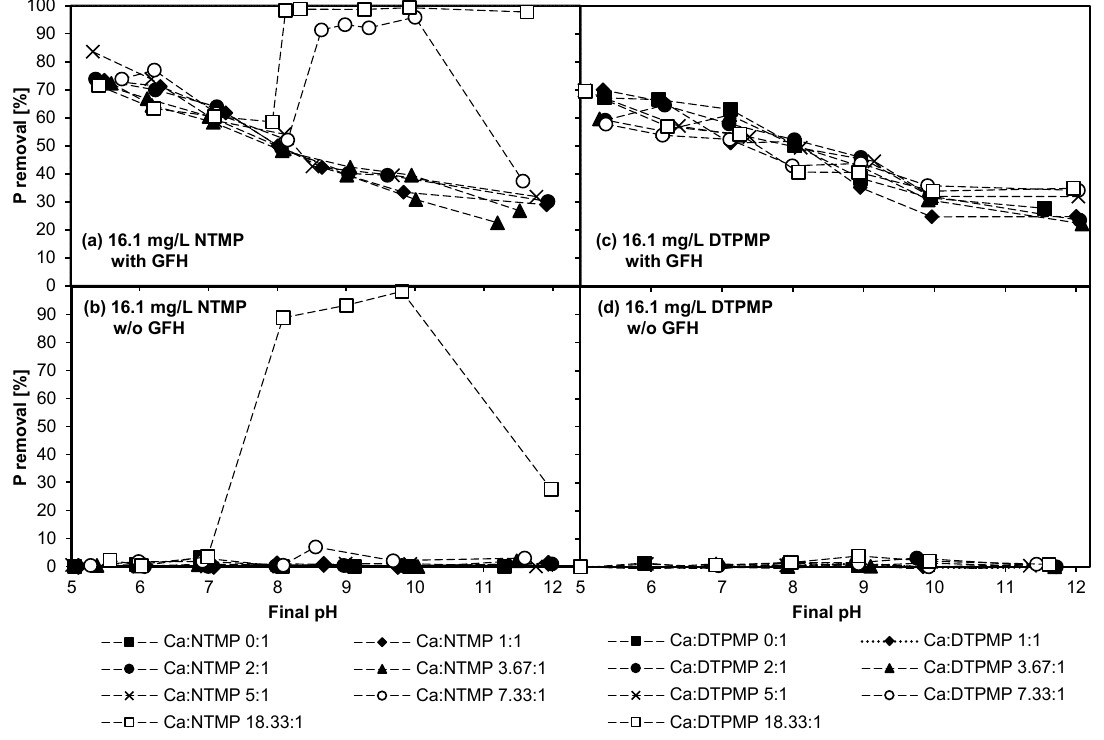
Figure 3. Influence of various molar Ca:phosphonate ratios on phosphonate adsorption (T = 20 ◦ C; t c = 7 d; initial concentration = 16.1 mg / L phosphonate; 0.2 g GFH / L and without GFH). ( a ) 16.1 mg / L NTMP with GFH, ( b ) 16.1 mg / L NTMP without GFH, ( c ) 16.1 mg / L DTPMP with GFH, ( d ) 16.1 mg / L DTPMP without GFH.